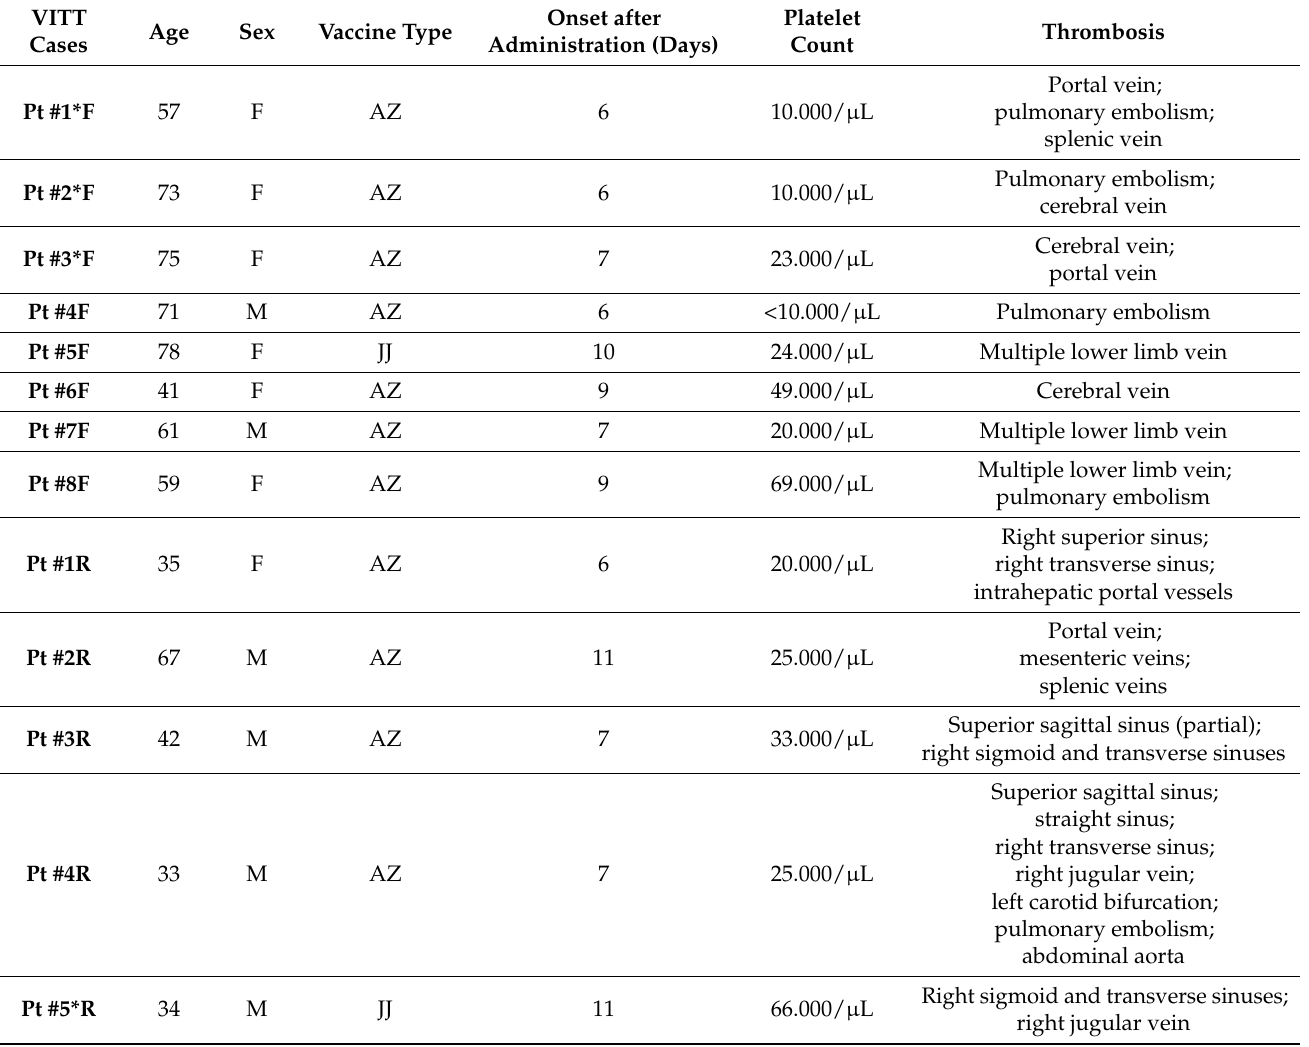
Table 1. Demographic and clinical characteristics of the study population. * Patients analyzed under IvIg